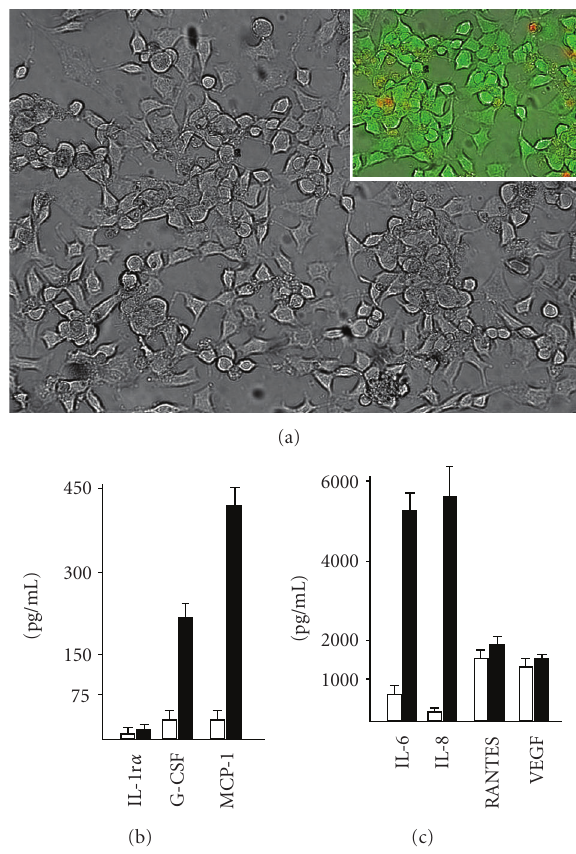
Figure 1: Morphology (a) and viability (insert) of IB3-1 cell monolayers, as determined by bright field and fluorescence pho- tomicrographs. Fluorescence photomicrographs were taken after double staining with Calcein-AM and propidium bromide. Analysis of the release of proinflammatory cytokines by IB3-1 cells, as deter- minated by Bio-Plex analysis (b,c). The indicated proteins were ana- lyzed in the IB3-1 cell culture medium, namely, IL-1r α (Interleukin- 1 receptor alpha), G-CSF (Granulocyte-colony stimulating factor), MCP-1 (Monocyte chemotactic protein-1), IL-6 (Interleukin 6), IL-8 (Interleukin 8), RANTES (Regulated upon activation, normal T cell expressed and secreted), and VEGF (Vascular endothelial growth factor). Data are referred to control untreated cells (open bars) and to cells treated for 24 hours with TNF- α (80ng/mL) (closed bars). Data represent the average ± SD ( N =